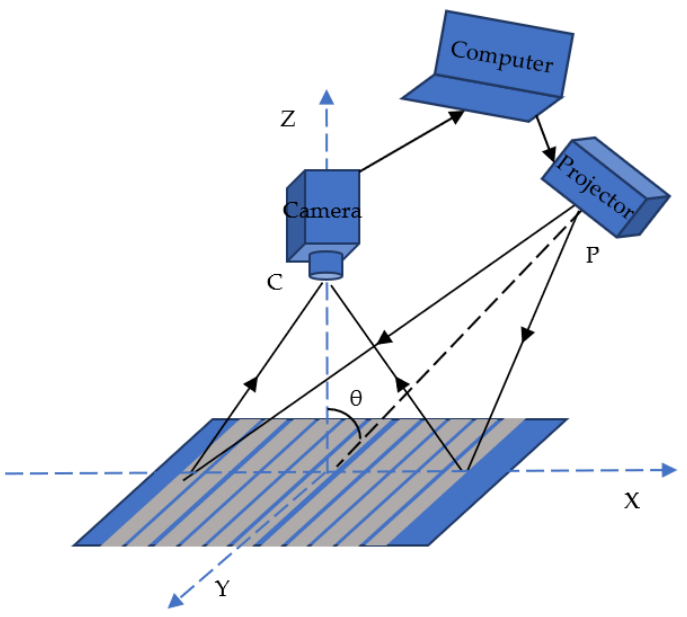
Figure 1. 3D reconstruction measurement optical system of MP.